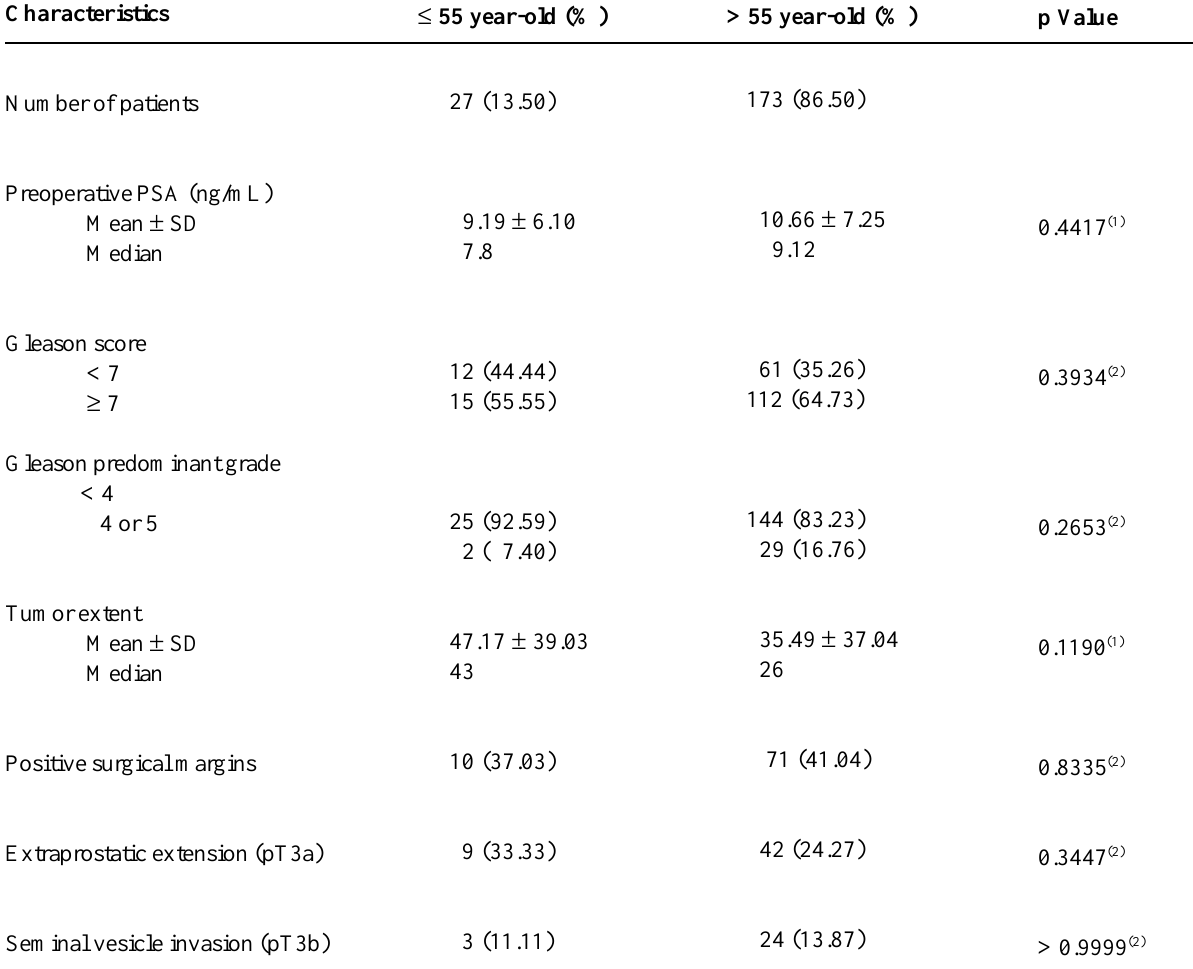
Table 1 – Clinicopathologic features of men undergoing radical prostatectomy, by